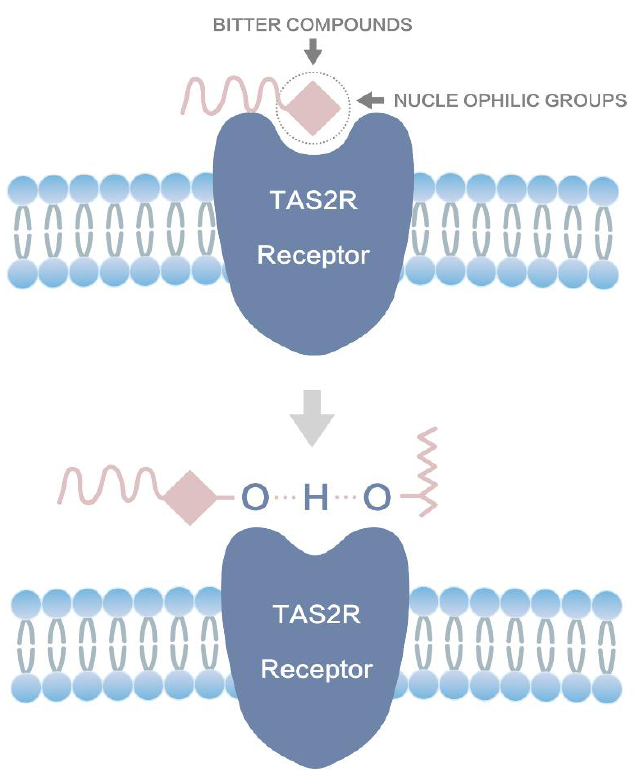
Figure 8. The taste-masking mechanism of chitosan with the TAS2R 10 receptor.